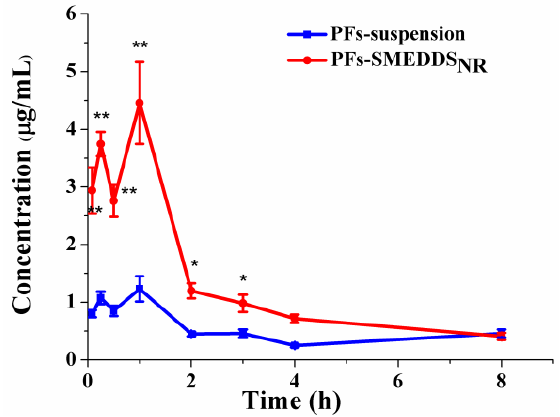
Figure 6. Plasma concentration–time profiles for oral administration of a suspension of PFs (PFs-suspension) and PFs-SMEDDS NR (116 mg/mL) in saline-pretreated rats (mean ± SD, n = 5; * p < 0.05 and ** p < 0.01). Table 1. Pharmacokinetic parameters of oral administration in saline-pretreated rats at a dose of 116